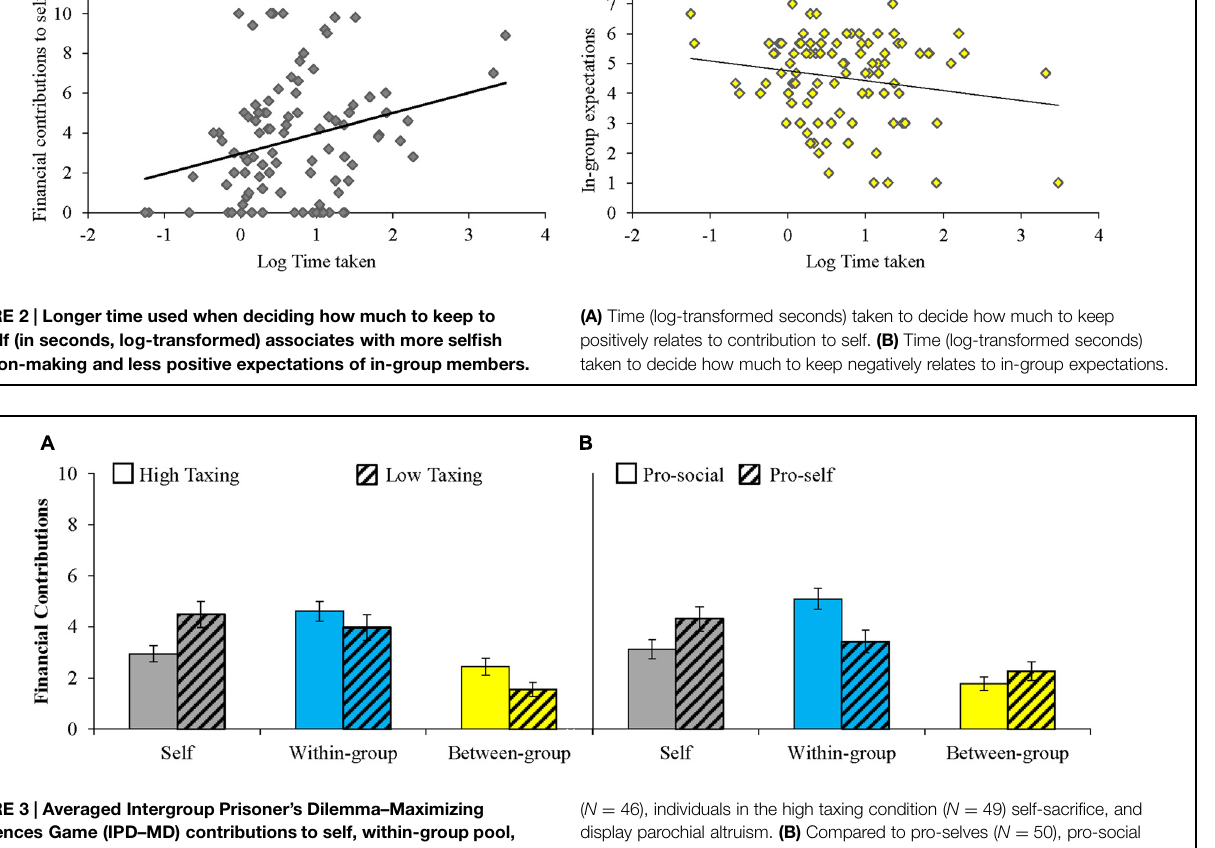
( N = 46), individuals in the high taxing condition ( N = 49) self-sacrifice, and display parochial altruism. (B) Compared to pro-selves ( N = 50), pro-social individuals ( N = 45) self-sacrifice, contribute more to the within-group pool, and display similar levels of parochial altruism.